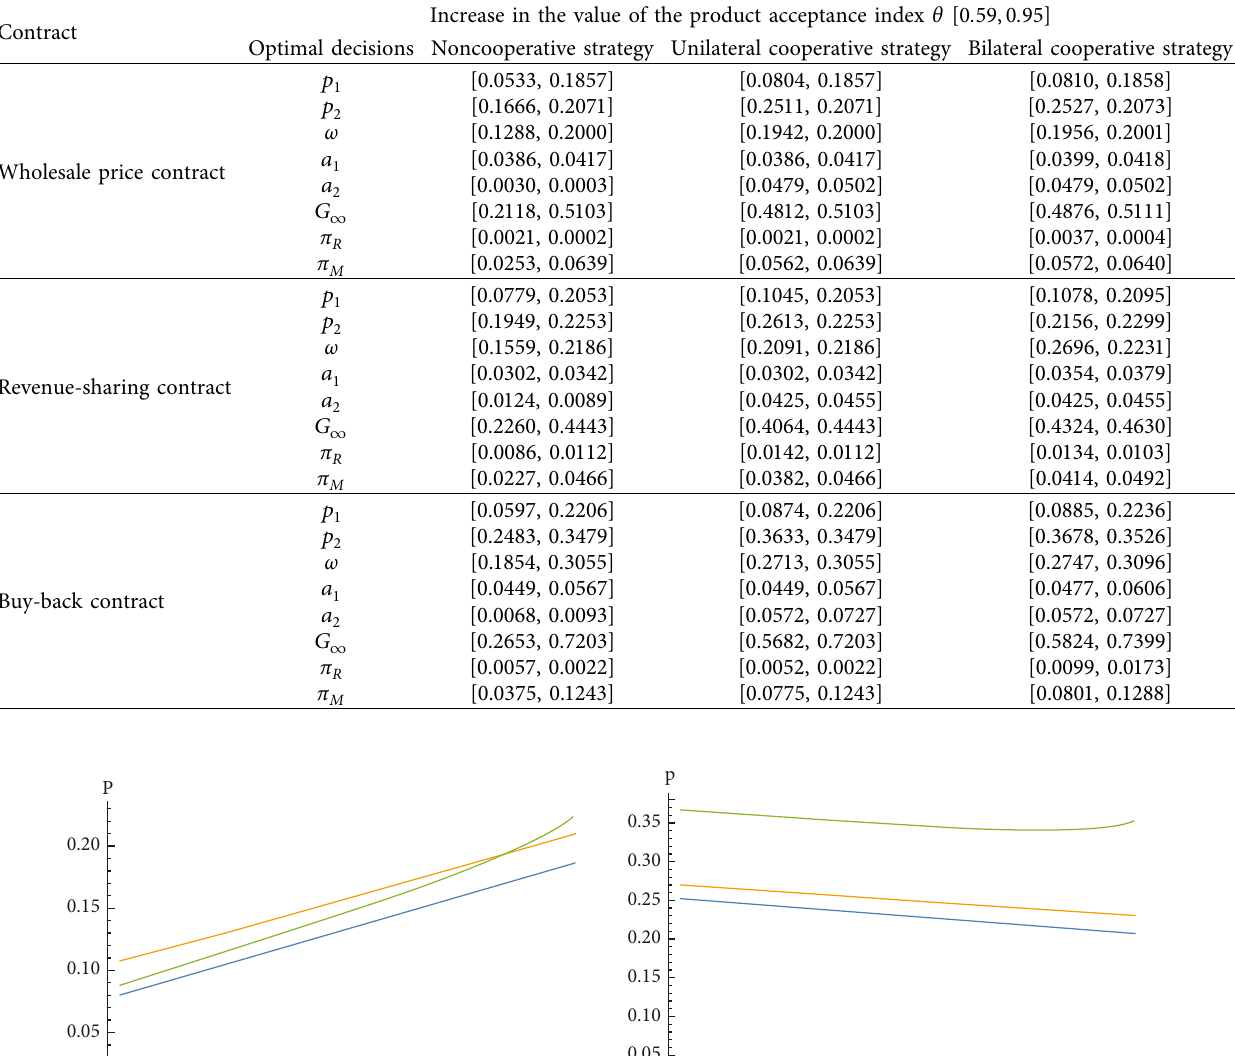
Table 8: Optimal analysis with respect to parameter θ changes.